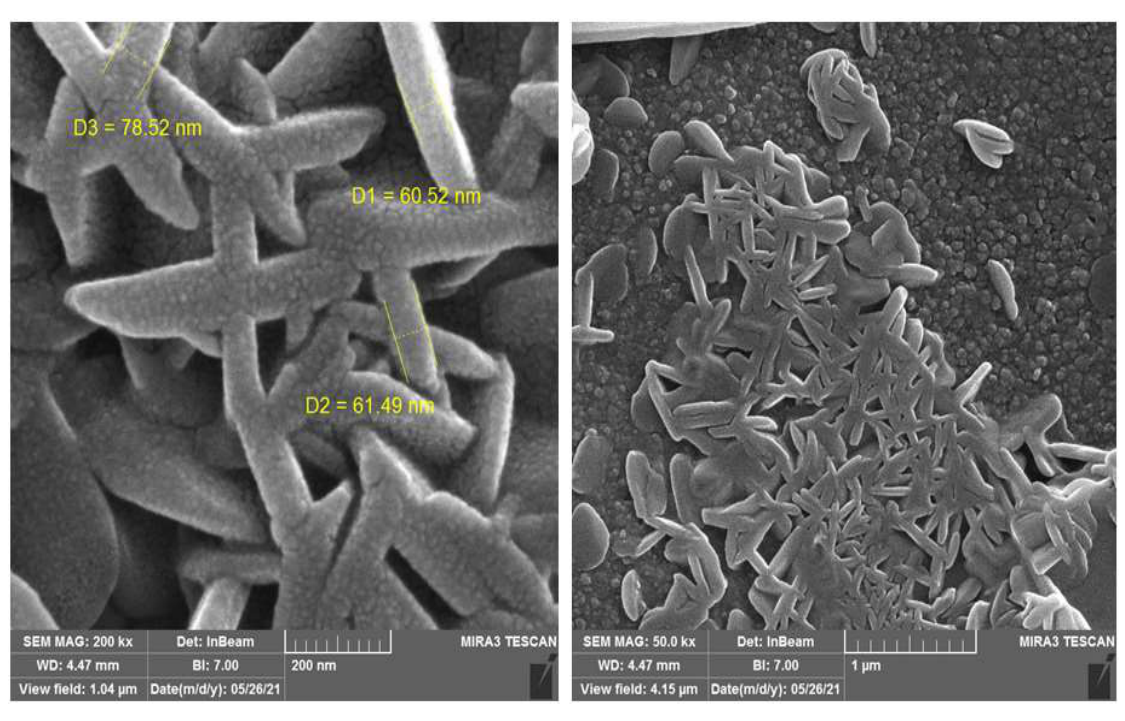
Figure 2: FESEM images of iron sulfide thin films prepared at 200 °C that it has particle-like